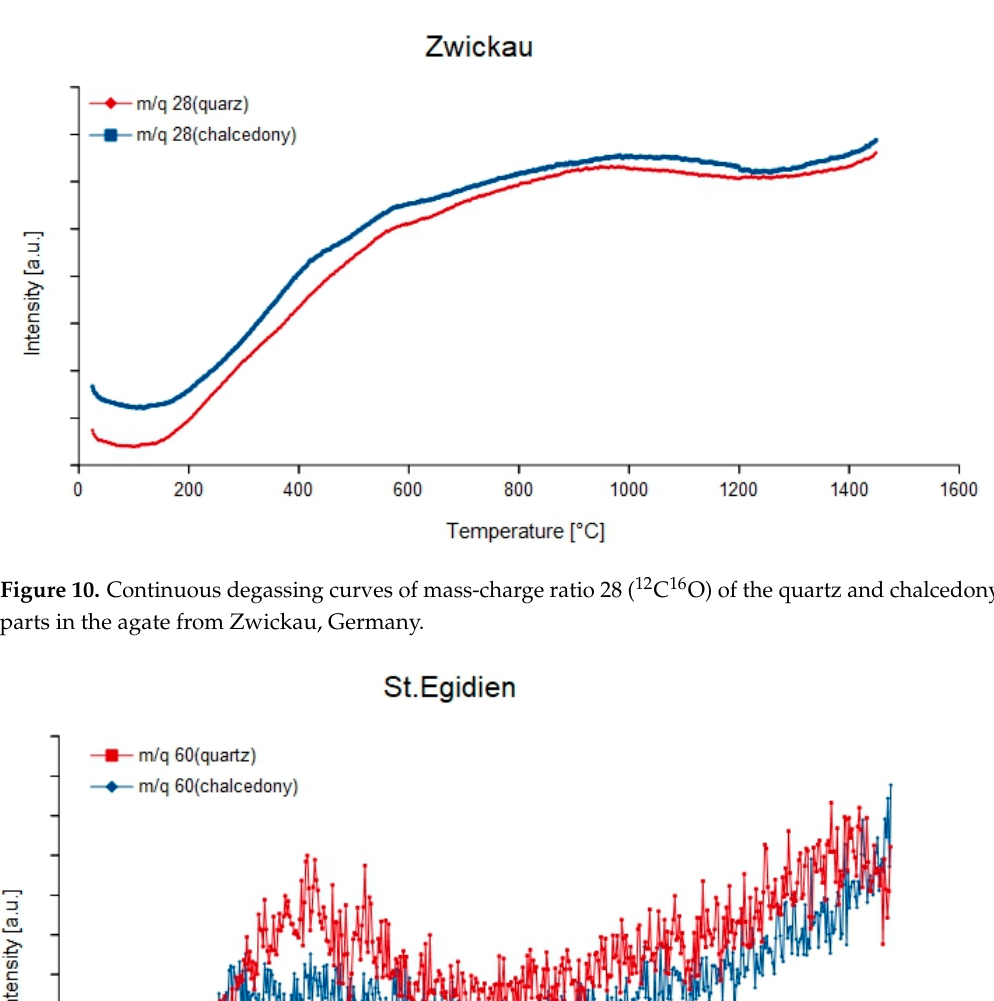
Figure 9. Degassing curves of the mass-charge ratio 20 ( 1 H 19 F) of quartz and chalcedony in the agate sample from St. Egidien, Germany.